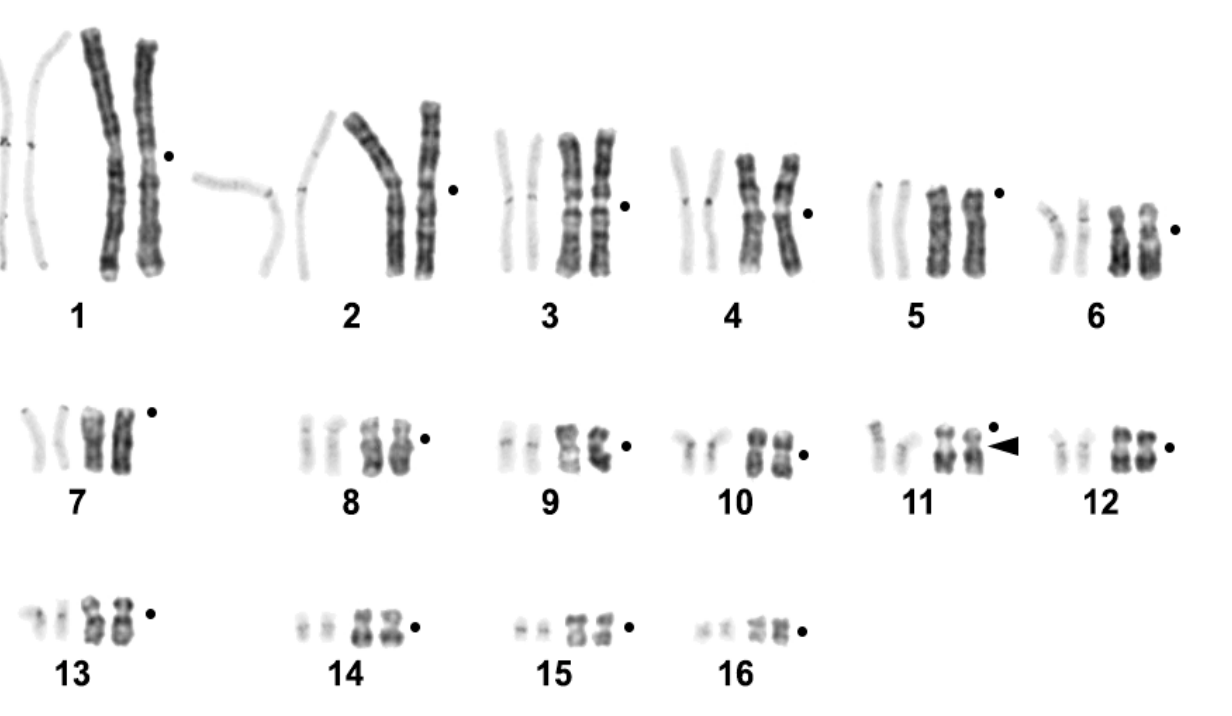
Figure 1. CBG- and GTG-banded Crocodylus niloticus karyotype. The black arrow marks the region of 18S/28S-rDNA probe localization. The black dots mark the positions of centromeres. CDAG-staining (Chromomycin A3-DAPI-after G-banding) makes it possible to reveal the AT-/GC-composition and heterochromatin position on differentially stained chromo- somes [38]. Intensive CMA 3 -positive pericentromeric blocks were seen in all C. niloticus chromosomes except pair 2. Chromosomes 6 and 11 carry large bright CMA 3 -positive blocks in p-arms. Weak 4 (cid:48) ,6-diamidino-2-phenylindole (DAPI)-positive blocks were re- vealed in pericentromeric regions of chromosomes 1 and 2 (Figure 2a). The 18S/28S-rDNA probe gave the only interstitial signal on the pair 11 (Figures 1 and 2b). Telomeric repeat (TTTAGG) n marked the distal parts of all chromosomal arms and did not demonstrate any interstitial signals (Figure